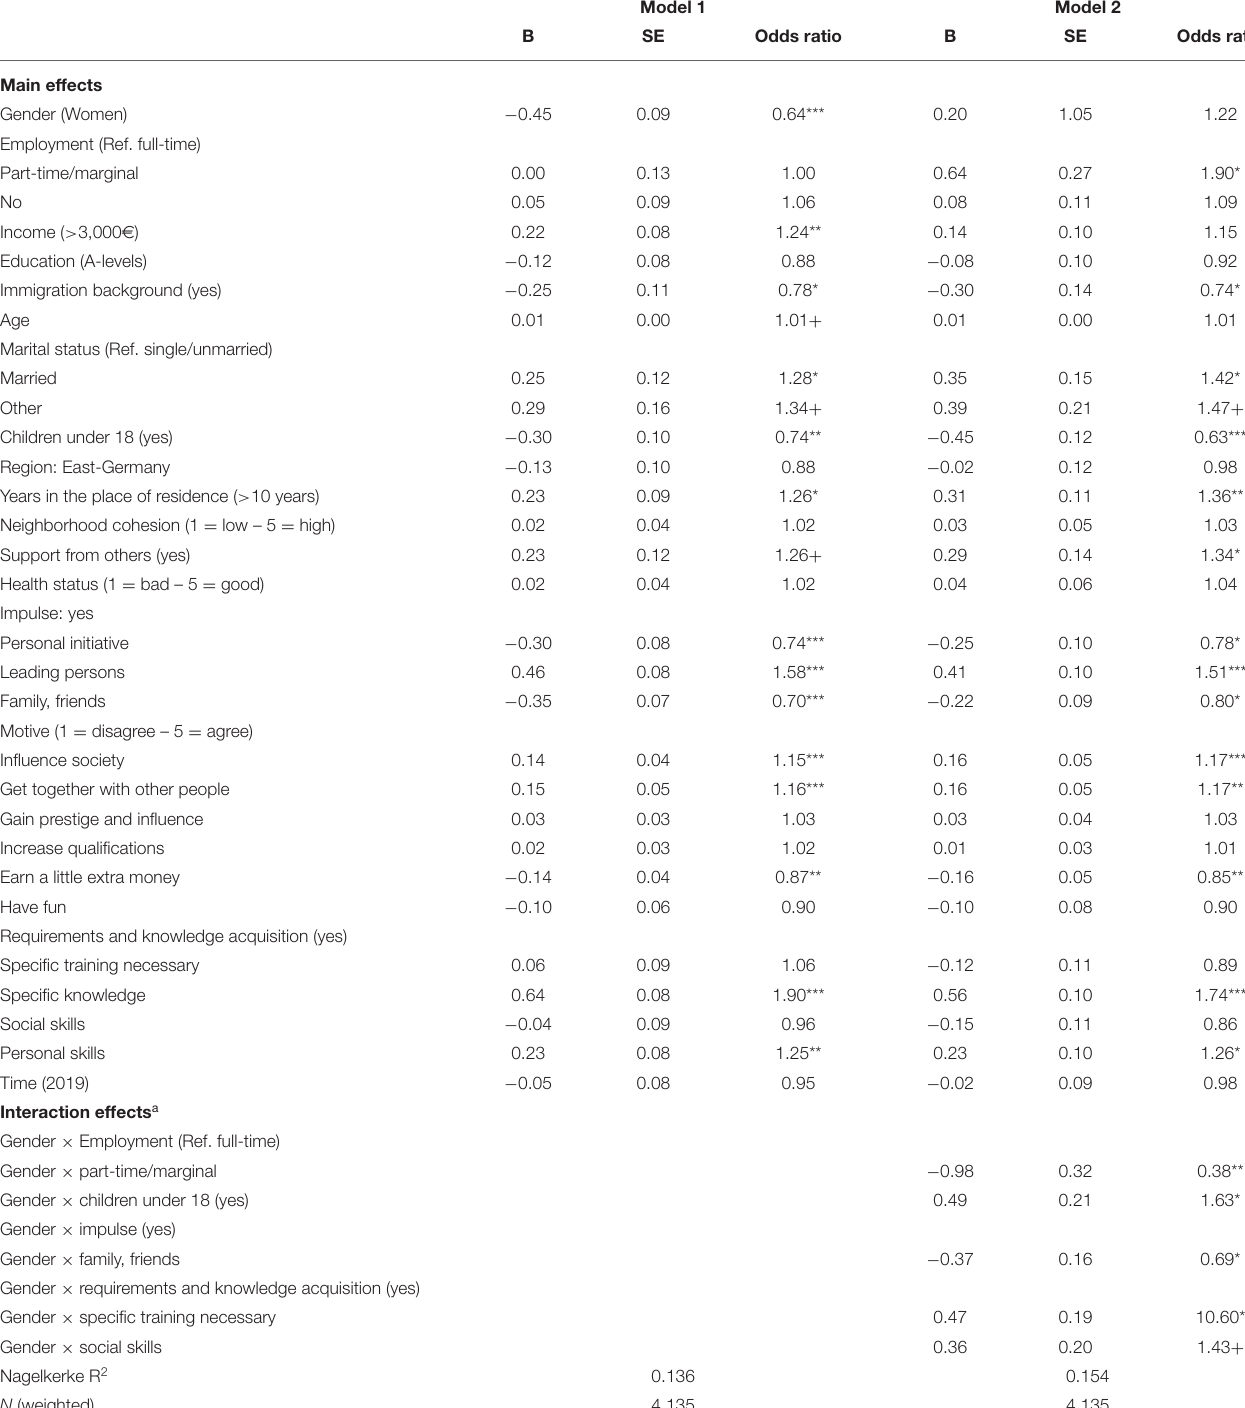
TABLE 8 | Predictors of leadership positions in sport in 2014 and